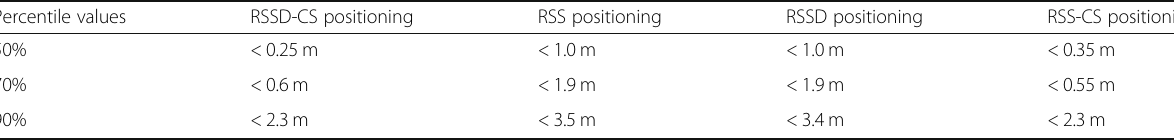
Table 1 Different percentile values concerning the positioning error under terminal homogeneous Percentile